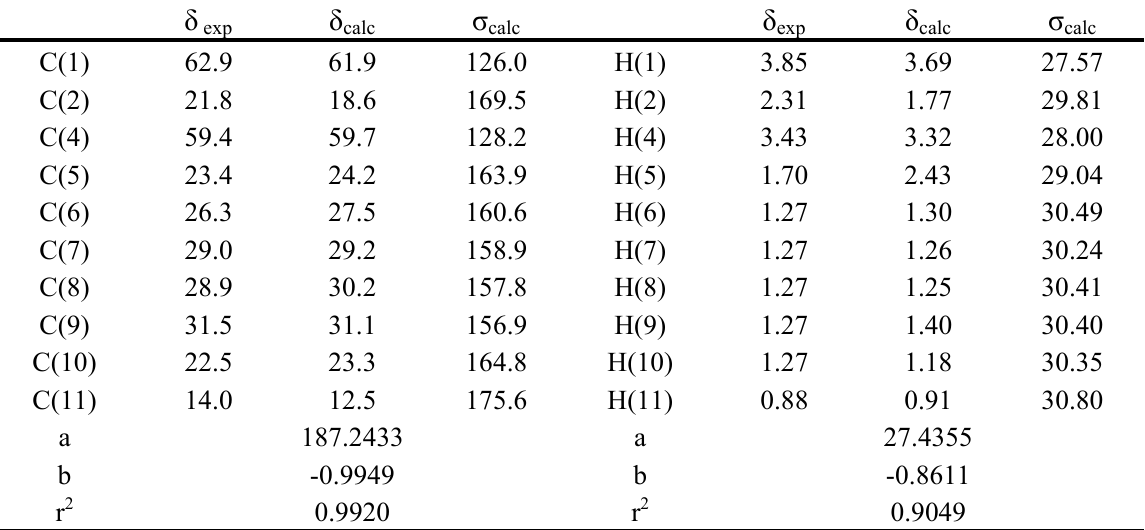
Table 5. Chemical shifts ( δ , ppm) in CDCl shielding ( σ ) for N,N -dioctylpyrrolidinium bromide ( 3 ). The predicted GIAO chemical cal shifts were computed from the linear equation δ from the fit the experimental